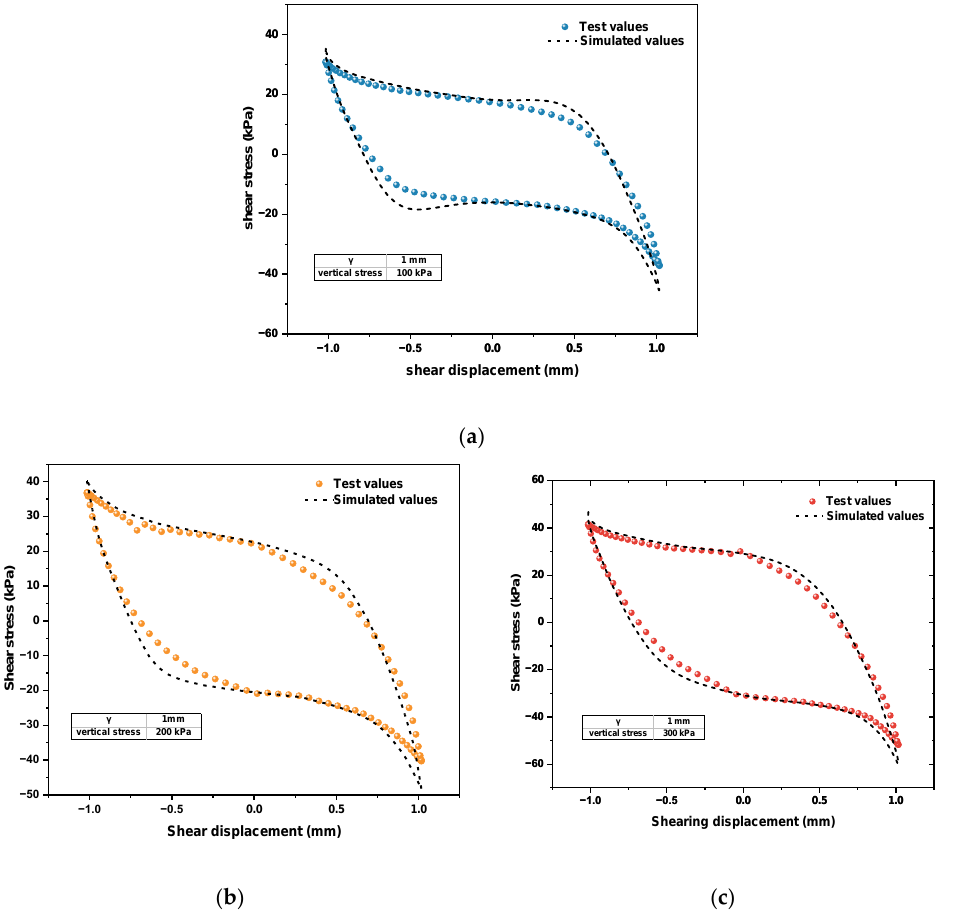
Figure 26. Dynamic shear stress – displacement relationship curves of polymer – soil cyclic shear simulation values and test values: ( a ) vertical stress = 100 kPa; ( b ) vertical stress = 200 kPa; ( c ) vertical stress = 300 kPa.